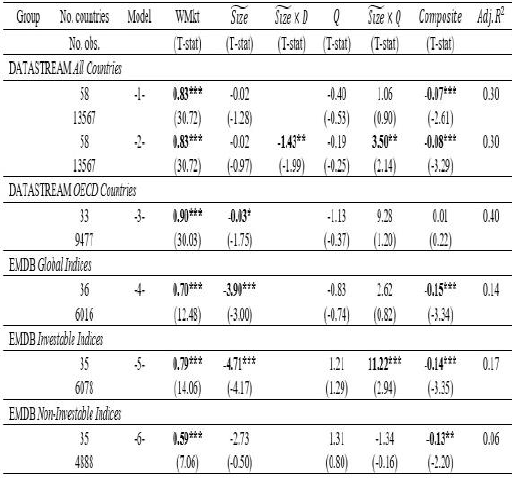
Table 9: Size and Segmentation Effects, controlling for Global Risk